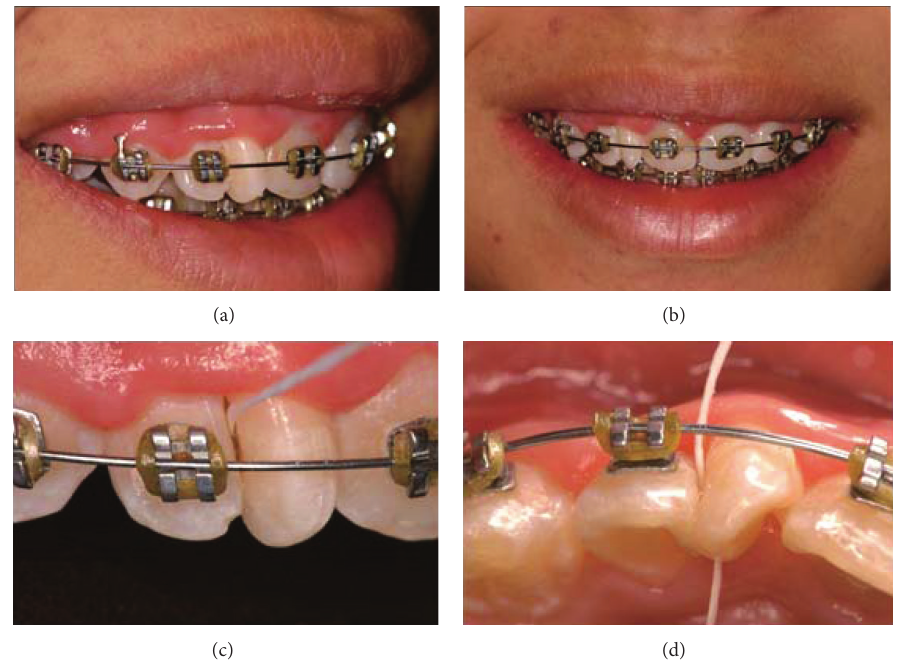
Figure 1: (a) Side view and (b) frontal view of the double teeth; observe the absence of interdental papilla and the midline deviation to the left. (c) Buccal view and (d) occlusal view of the double teeth with flossing to assist the diagnosis.